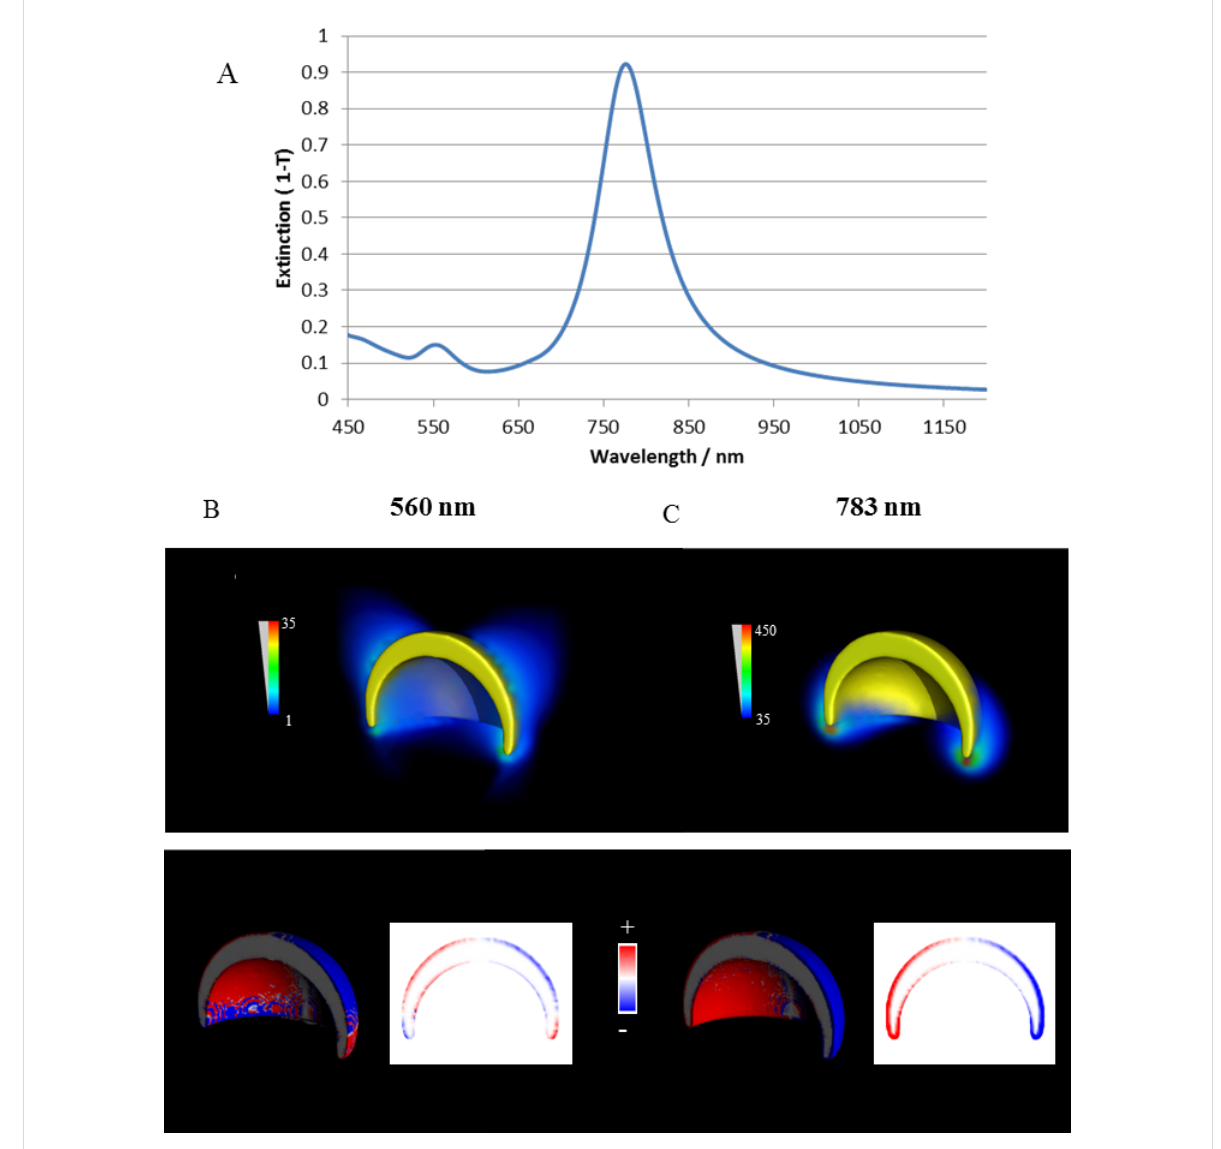
Figure 5: A) Simulated extinction spectra of a 20 nm thick gold cap (110 nm in diameter). Underneath the E-field intensity (| E | 2 /| E 0 | 2 ) and charge density plots for the peaks at 560 nm (B) and 783 nm (C) are shown. The direction of the light propagation is normal to the surface and the polariza- tion horizontal in the figure